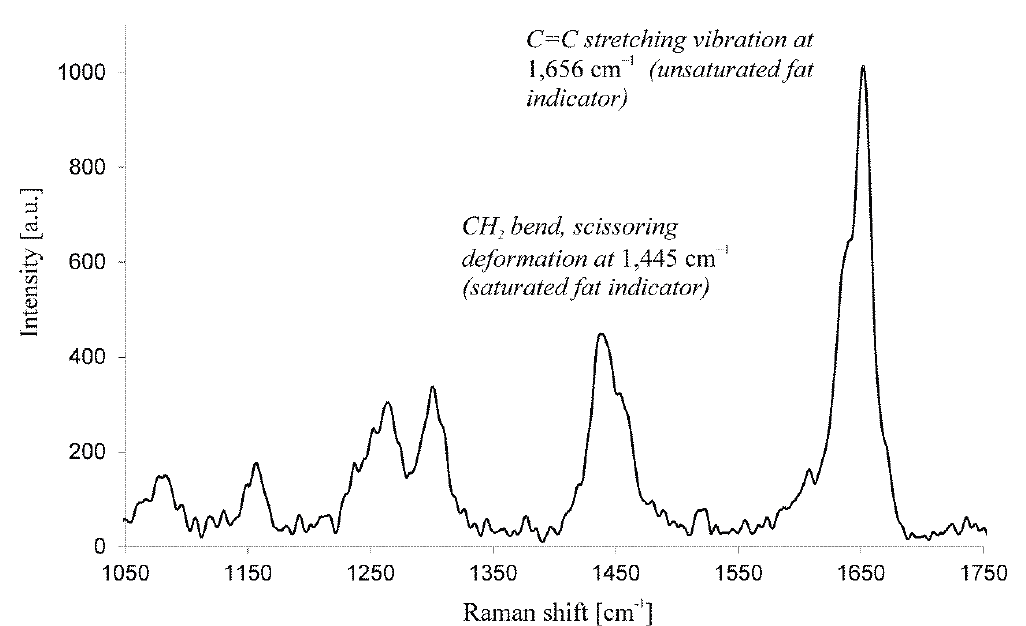
Figure 1. Raman spectrum of a lipid body within the algae ( Trachydiscus minutus ). From the ratio of intensities I 1656 /I 1445 the iodine value (IV) can be estimated [42]. Here algal lipid content is close to IV ~